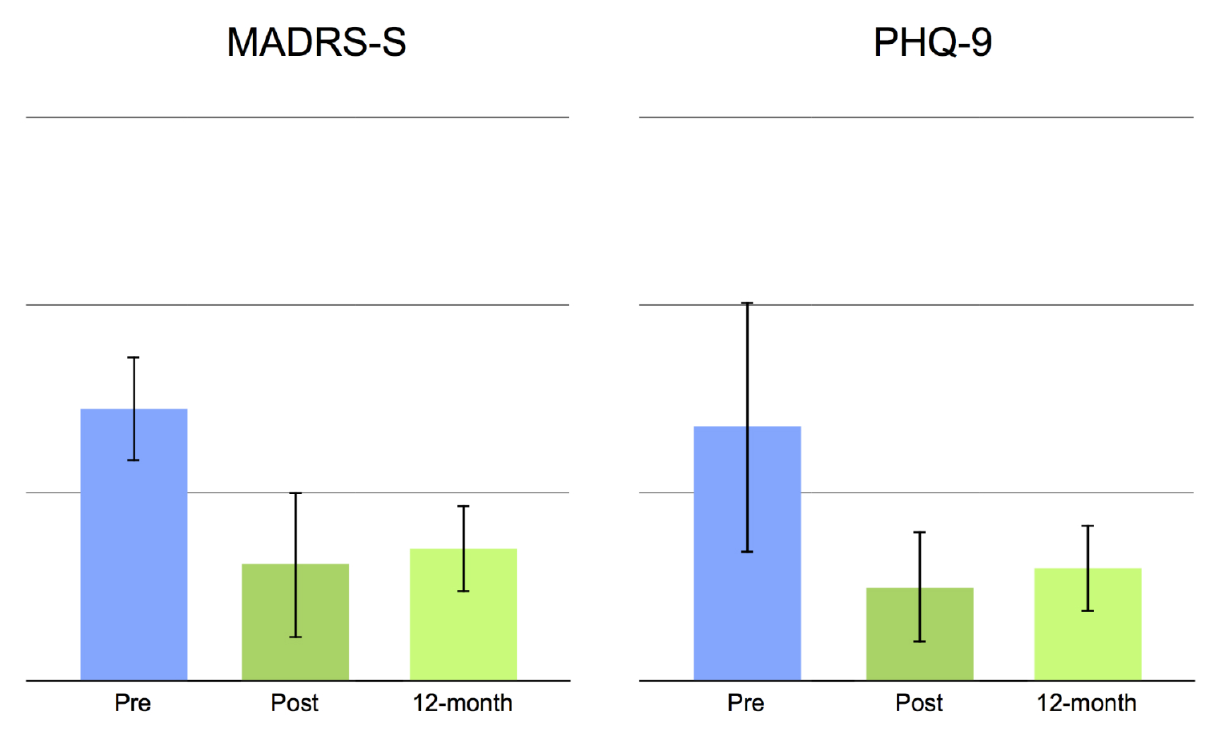
Figure 3. Histograms showing clinical measures of depression. Mean values at pre-treatment, post-treatment, and at 12-month follow-up. Error bars represent the standard deviation.